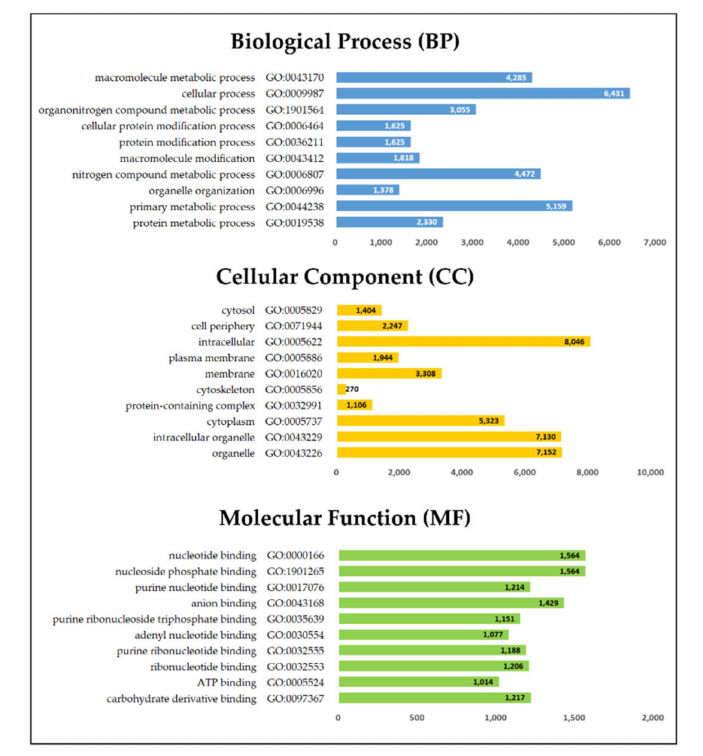
Figure 3. Histogram of GO terms of union SNPs in rapeseed mutant